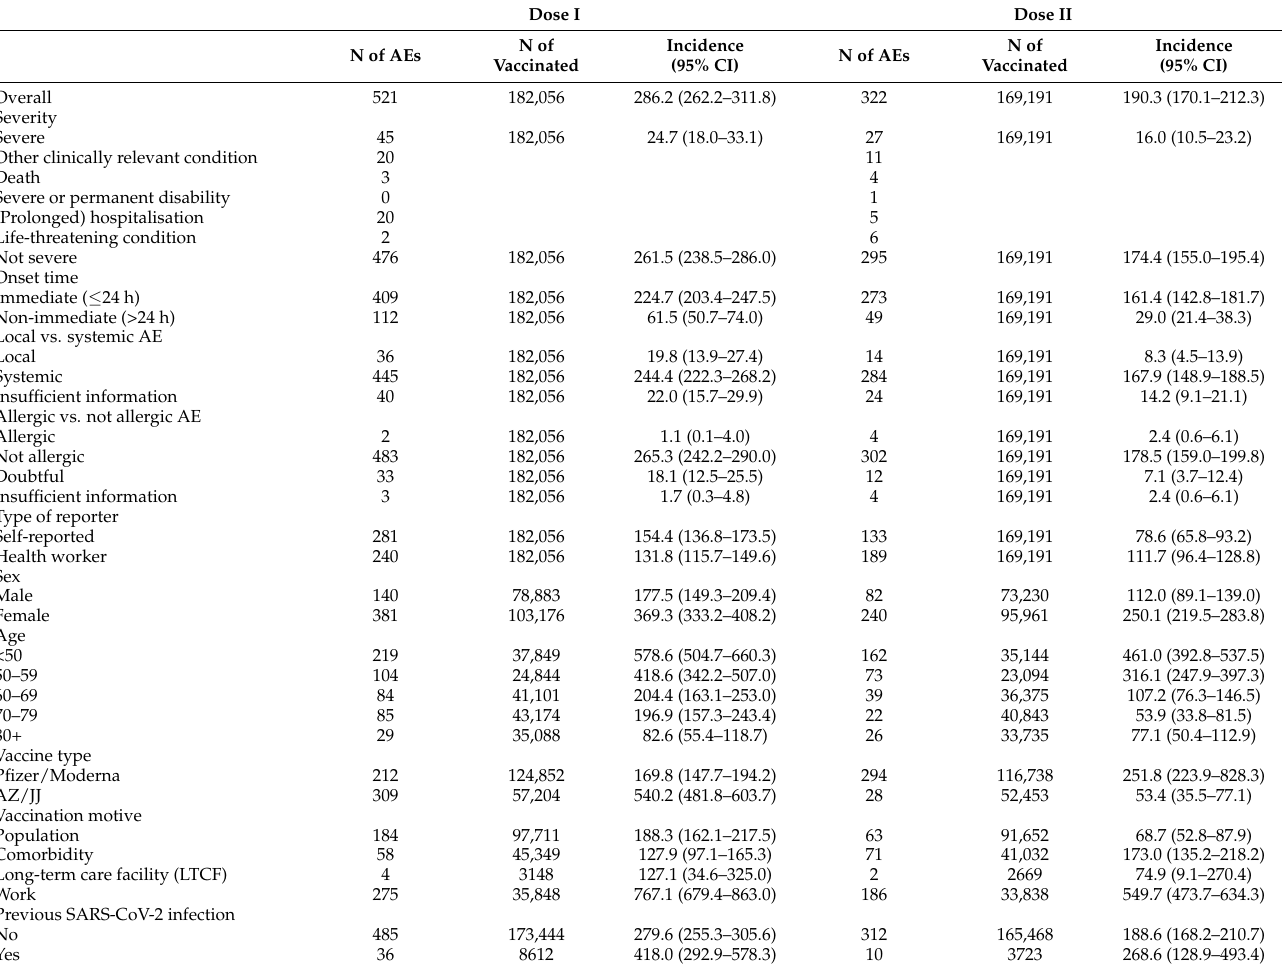
Table 1. Total number of AEs after first and second dose.